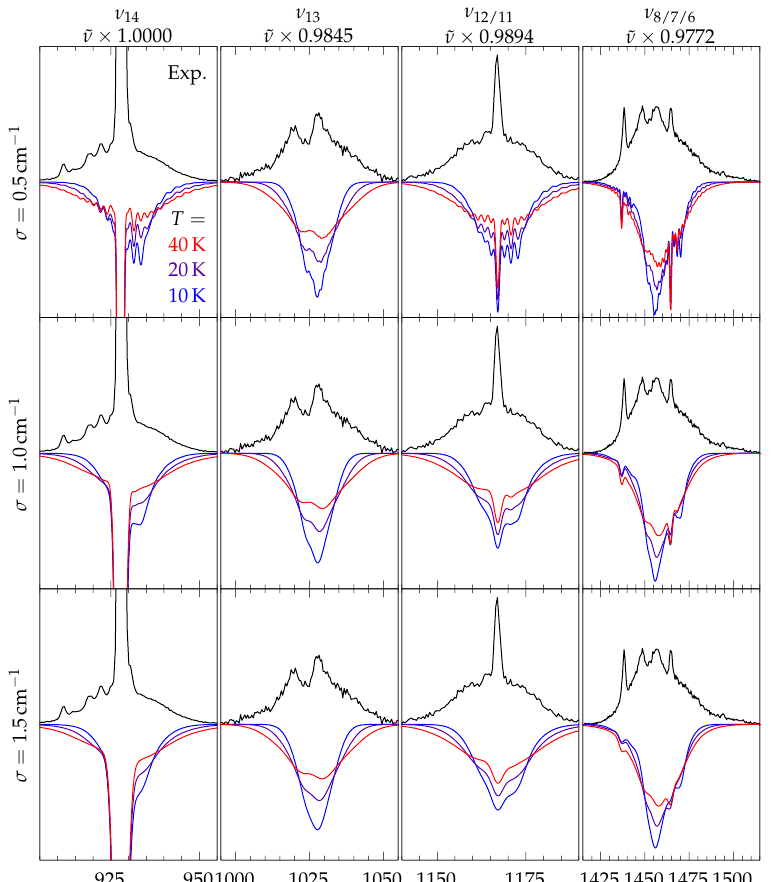
Figure 5. Near-baseline sections of the jet spectrum of methyl methanoate (black trace) and rovibra- tional simulations for different temperatures T and Gaussian widths σ . Calculated wavenumbers are scaled by the factors provided below the vibrational labels and calculated intensities are scaled to match the integrated experimental intensity.